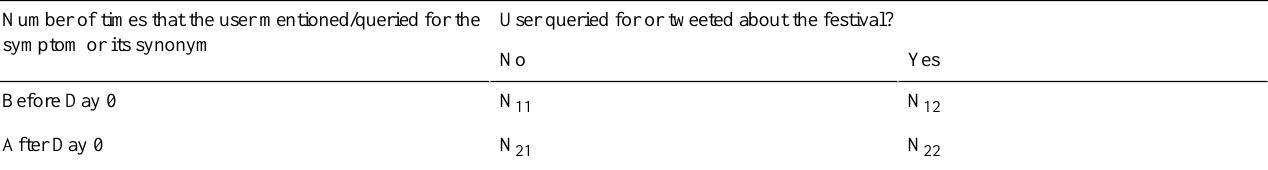
User queried for or tweeted about the festival?Number of times that the user mentioned/queried for the